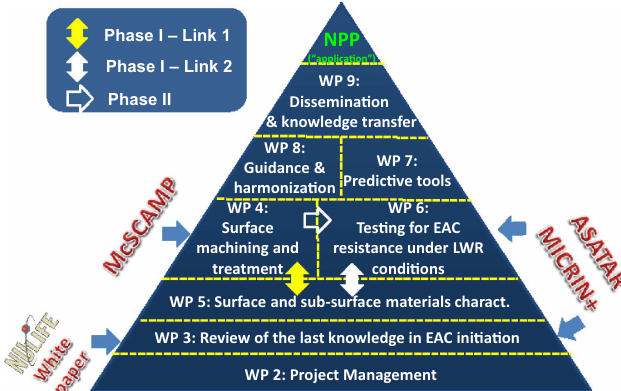
Fig. 1. WP structure of MEACTOS project and interaction with previous projects from NUGENIA+